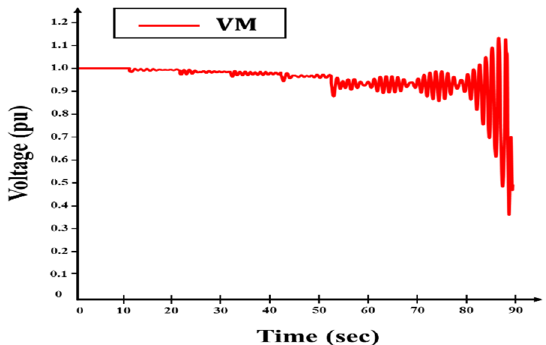
Figure 15. Voltage magnitude of virtual bus in the power sending part depends on the contingencies.